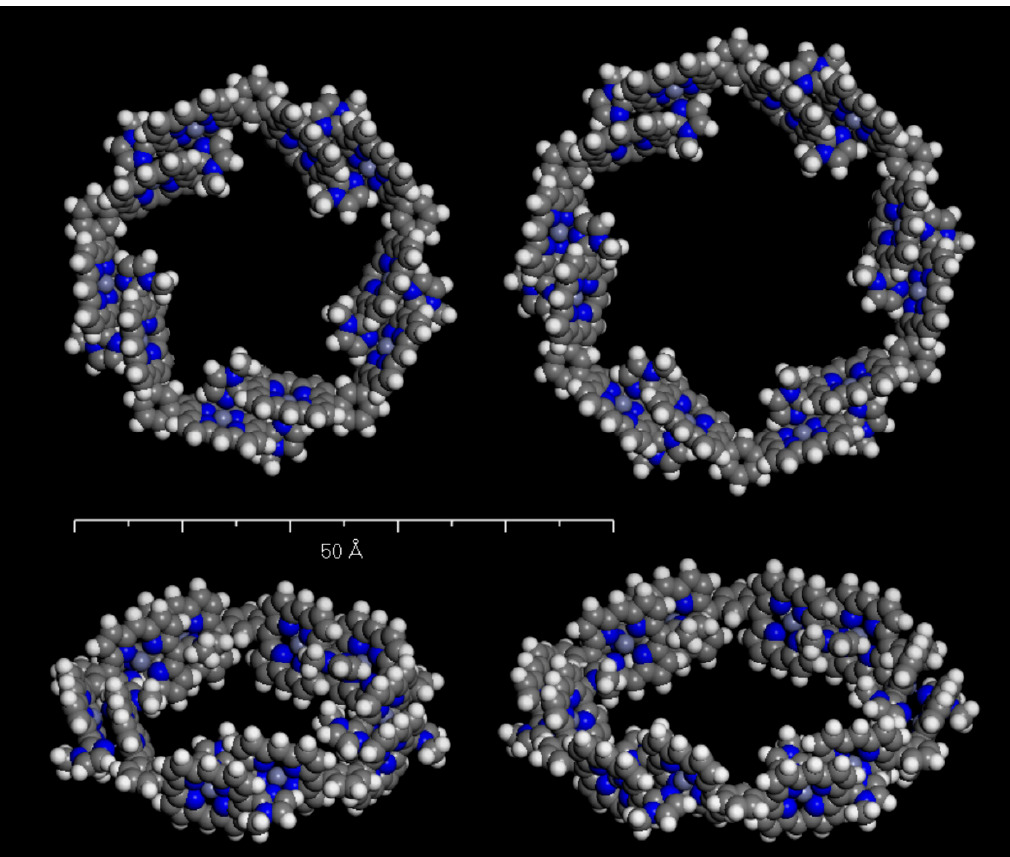
Figure 4. Molecular models of self-assembled (left top and bottom) pentamer and (right top and bottom) hexamer of GP1 s prepared on Materials Studio ® . Gray: carbon, blue: nitrogen, dark blue: zinc, white: hydrogen atoms. Substituents on meso -positions are omitted for clarity.